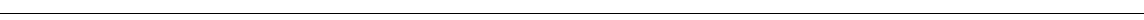
Fig. 7 Metabolic phenotypes of Wy-offspring during high-fat diet (HFD) feeding. a Experimental protocol of Veh-offspring and Wy-offspring fed HFD diet, which are referred to as Veh-HFD and Wy-HFD, respectively. The gray-shaded box indicates the period of maternal administration of Wy or Veh. b , c Body weight changes ( b ) and total food intake during HFD feeding ( c ) ( n = 11 per group, statistics by two-way ANOVA with repeated measures). d Tissue weight of Wy- and DMSO (Veh)-treated HFD mice at 14W ( n = 11 per group). e Hematoxylin and eosin (HE) staining (top, representative image of ten individuals per group) and quanti fi cation of adipocyte diameter (bottom) of eWAT. Histograms of adipocyte diameter (bottom left). Horizontal lines with bilateral squares indicate interquartile range (IQR). Arrows indicate the median values (numbers above the horizontal lines) of Veh-HFD and Wy-HFD. Statistical analysis (bottom right) of mean adipocyte diameters are shown. Scale bar = 100 µ m ( n = 10 per group). f Bisul fi te-sequencing analysis (left, representative data of three independent experiments) and graphical presentation of statistical analysis (right, n = 4 – 5 per group) of Fgf21 in Wy-HFD and Veh-HFD at 4W and 14W. g Hepatic Fgf21 mRNA expression in Wy-HFD and Veh-HFD at 14W. ( n = 10 per group). h Circadian variation of serum FGF21 concentrations. ZT, zeitgeber time ( n = 11 per group). i Relative mRNA expression of Egr1 , c-fos , Hsl , and Atgl in eWAT ( n = 10 per group). Statistics by unpaired Student ’ s t -test otherwise indicated. Data are expressed as mean ± SEM. * P < 0.05; ** P < 0.01; *** P < 0.001; N.S., not signi fi cant vs.